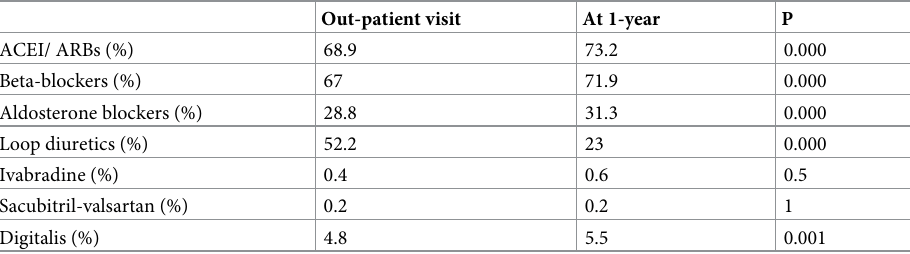
Table 7. Pharmacological treatment of CHF patients during outpatient visit and at 1-year. Out-patient visit